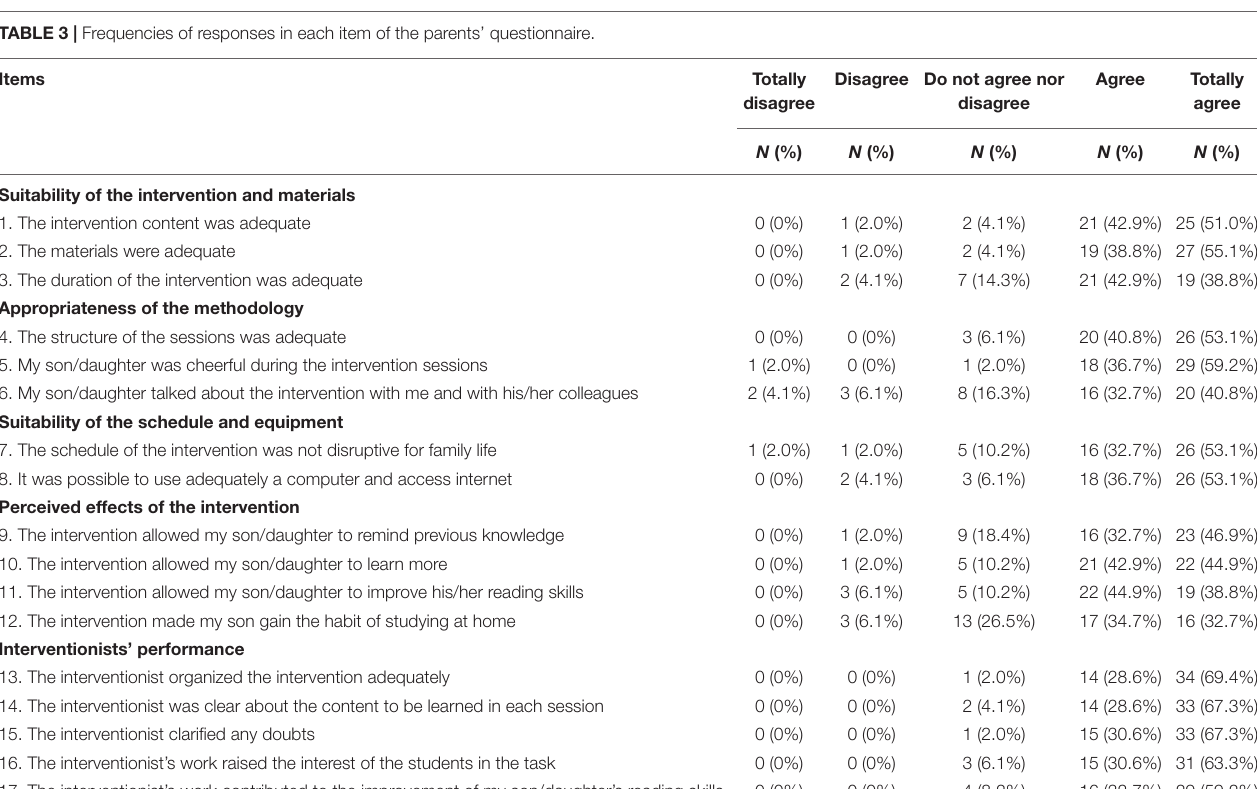
TABLE 3 | Frequencies of responses in each item of the parents’